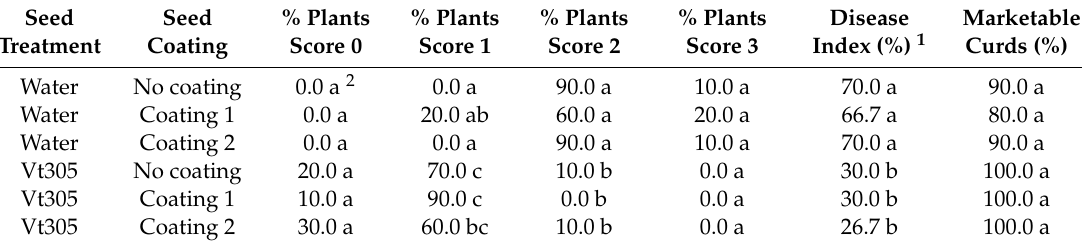
Table 2. Biocontrol of Verticillium wilt of cauliflower in field conditions at Ardooie in 2013 when the PHYTO-DRIP ® system was used to deliver microsclerotia of V. isaacii Vt305 on seeds. Cauliflower